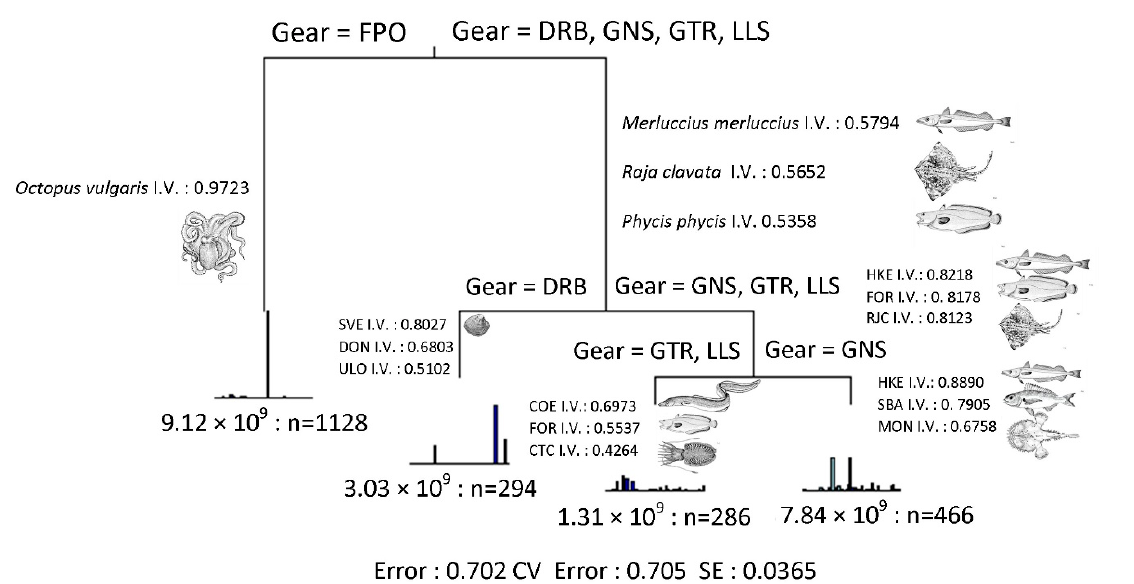
Figure 1. Multivariate regression tree (MRT) with 3 splits and 4 leaves, where gear type is the strongest factor, with the indicator species (I.V. indicator values), the percentage of deviance explained and the number of vessels representing each node. (FPO = Traps; DRB = Dredges; GTR = Trammel nets; GNS = Gillnets; LLS = Longlines).